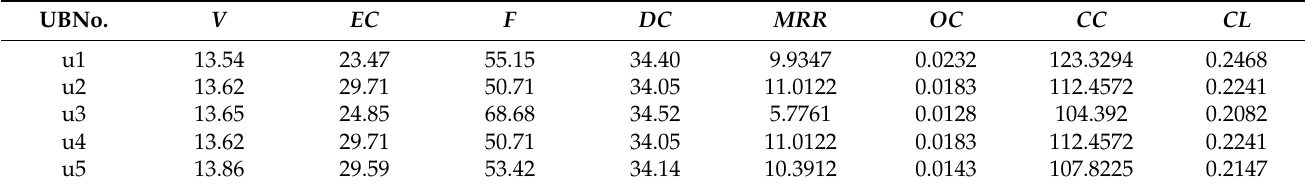
Table A12. Unemployed bees ( UBNo i ).